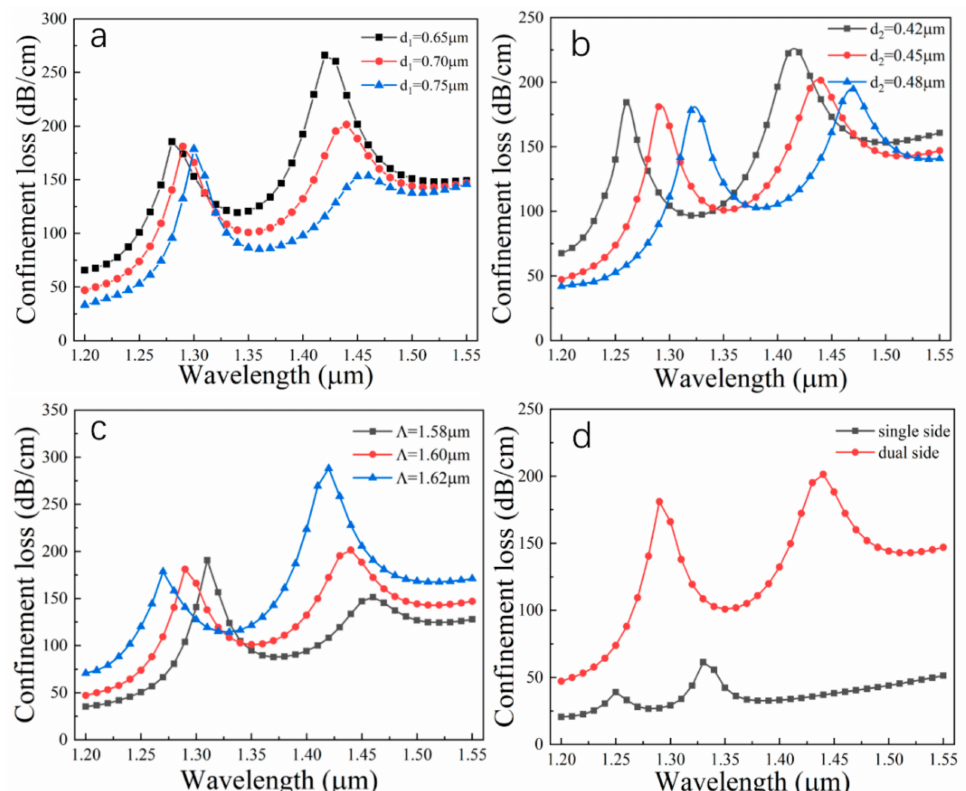
Figure 4. Dependence of loss spectra on di ff erent structural parameters: ( a ) di ff erent d 1 ; ( b ) di ff erent d 2 ; ( c ) di ff erent Λ ; ( d ) comparison of dual-side coating and single-side coating. Here, t Au = 50 nm, t Si3N4 = 50 nm and n = 1.410; the control variates method is adopted to analyze the